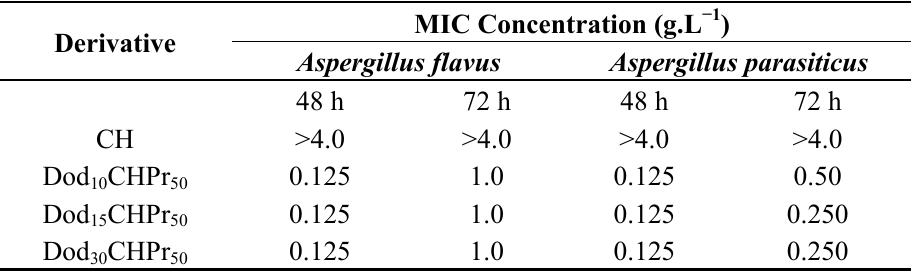
Table 2. Minimum Inhibitory Concentrations of chitosan and its amphiphilic derivatives